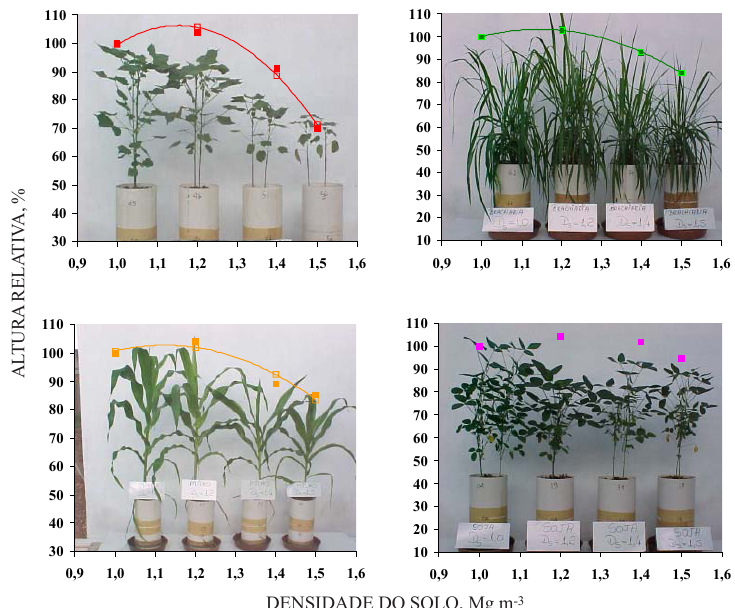
Figura 2. Altura relativa observada ( ) e estimada pelo modelo ( ) para plantas de algodão,